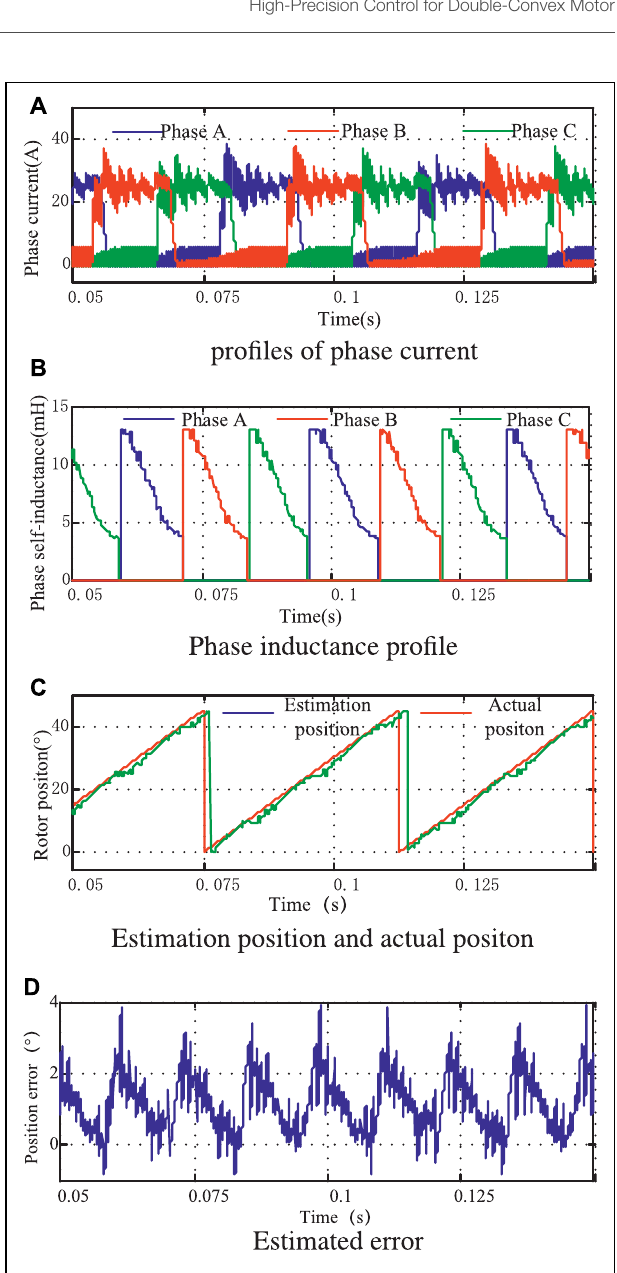
FIGURE 8 | Simulation results with the traditional estimation method under fractional load. (A) Profiles of phase current. (B) Phase inductance profile. (C) Estimation position and actual position. (D) Estimated